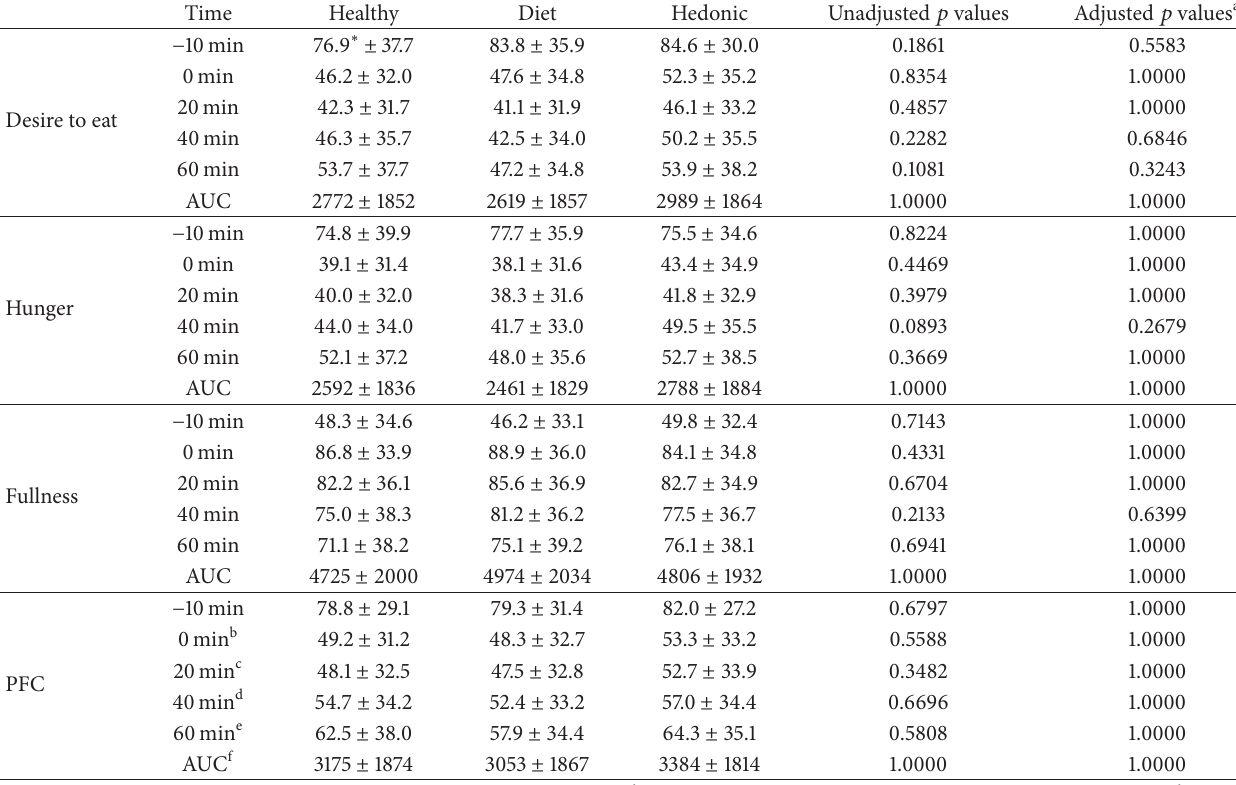
Table 3: Appetite VAS values (mm) at each time point and their related AUC (mm × 60 min) for each experimental